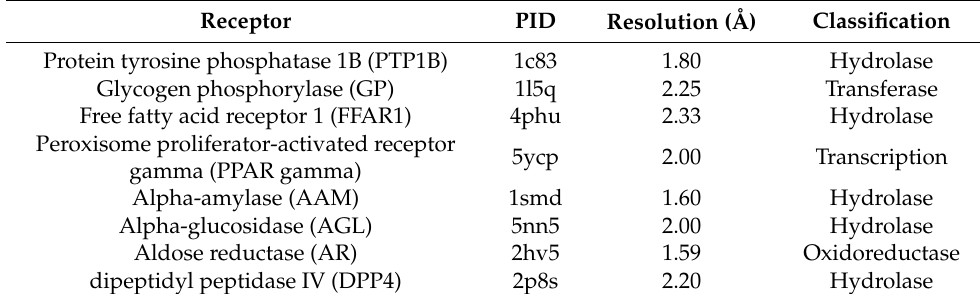
Table 3. Selected receptors